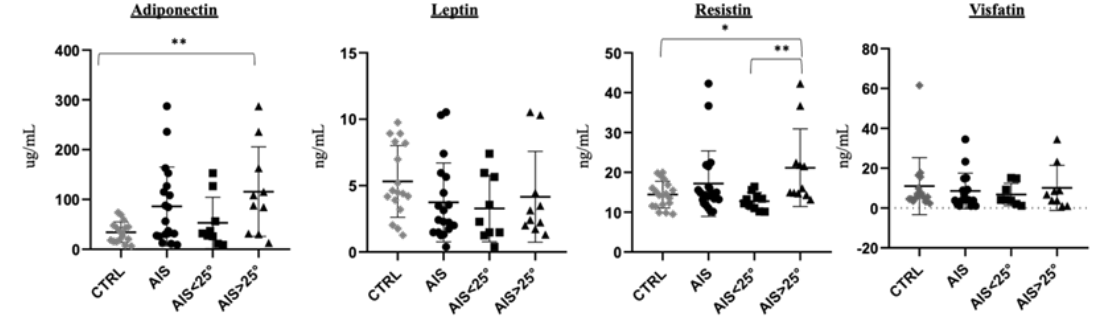
Figure 3. Adipokine levels in control and AIS participants. AIS participants were divided based on curve severity with Cobb angles < 25° or >25° as the cut-off point. Plasma adipokine levels were assessed by multiplex immunoassays in n = 19 CTRL, n = 21 AIS, n = 10 AIS < 25° and n = 11 AIS >25°. * p < 0.05, ** p < 0.01 Mann-Whitney test. CTRL: Controls; AIS: Adolescent idiopathic scoliosis. Table 5. Fasting levels of metabolic parameters in control and AIS participants.